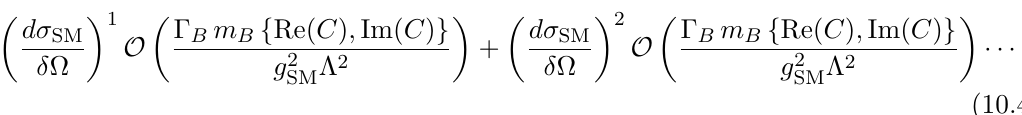
(cid:22) (cid:22) (cid:22) due to (6) which is indicated with a black ! L